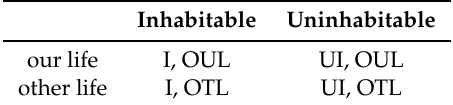
Table 1. Hierarchy of multiverses in view of our definition of life.